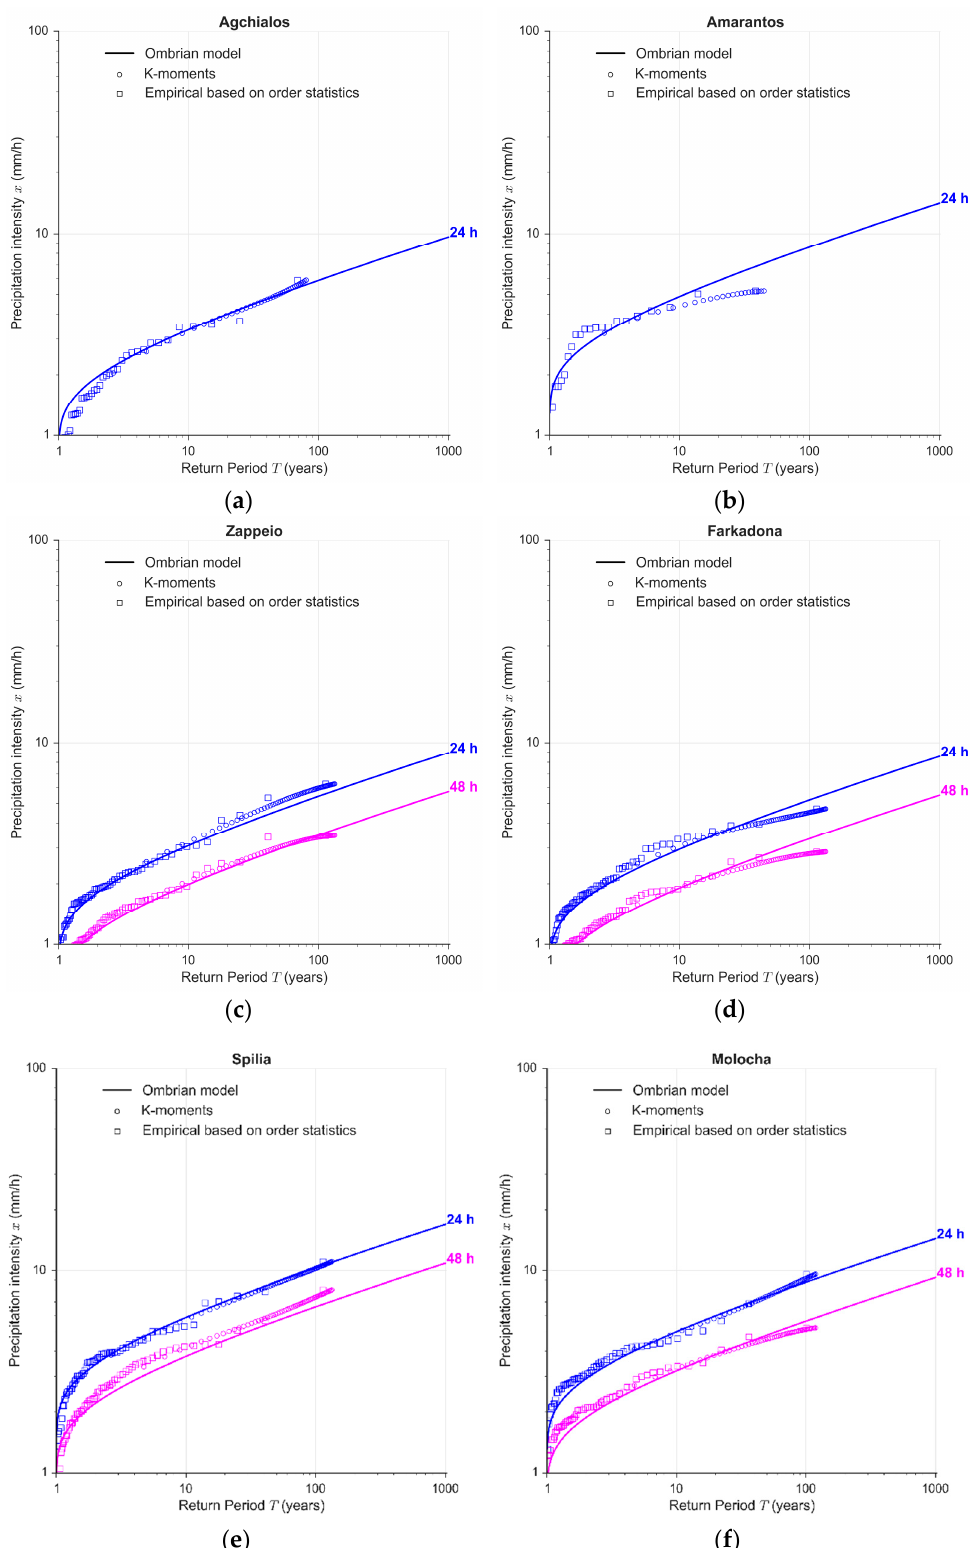
Figure 7. Theoretical and empirical distributions of 24 h and 48 h annual maximum intensities (depending on the available samples) in characteristic stations of Thessaly’s WD: ( a ) Agchialos, ( b ) Amarantos, ( c ) Zappeio, ( d ) Farkadona, ( e ) Spilia and ( f ) Molocha. The empirical intensities plotted based on order statistics are also shown for validation.